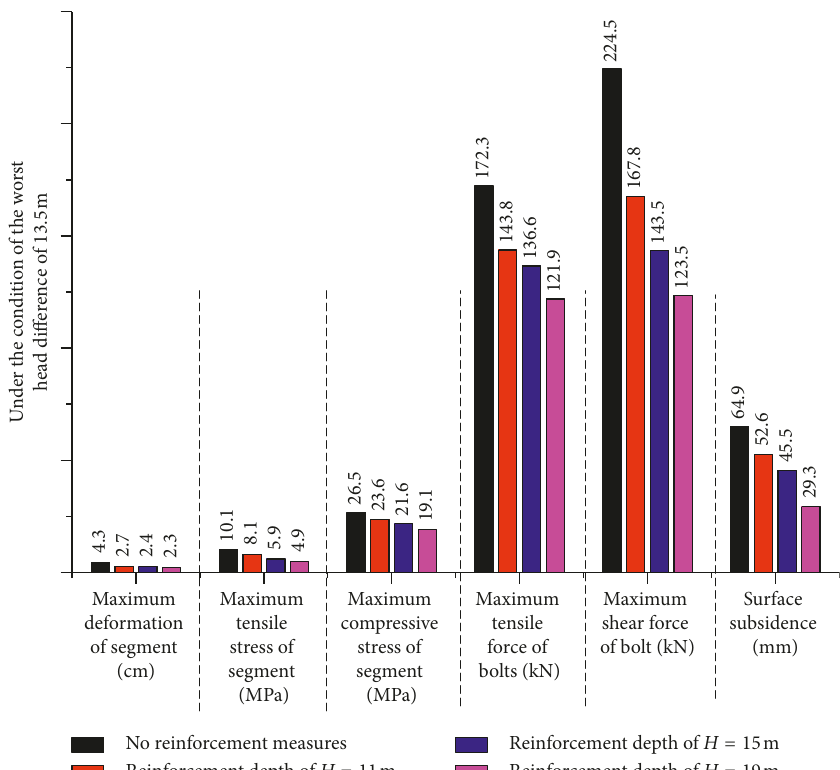
Figure 25: Efficiency percentage weight of emergency control measures with different reinforcement